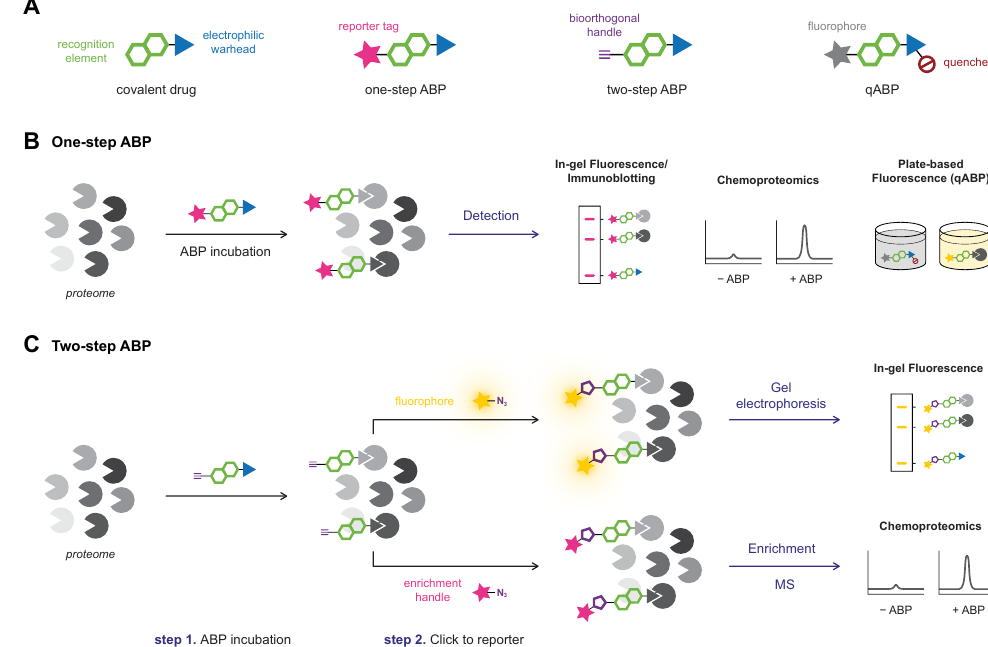
Figure 9. Strategies for covalent adduct detection with drug-derived activity-based probes (ABPs). ( A ) General design principle for covalent drug-derived ABPs. A fluorophore, detection tag, or enrichment handle is introduced onto the parent covalent drug bearing a recognition element and a covalent warhead. ( B ) Detection of covalently modified proteins with one-step ABPs. Proteome is treated with one-step ABP, proteins are resolved by gel electrophoresis or affinity purification, and modified targets are detected by in-gel fluorescence or immunoblotting or by chemoproteomic evaluation. ( C ) Detection of covalent adducts with two-step ABPs. Proteome is incubated with a two-step ABP bearing a small bioorthogonal handle ( step 1 ), followed by bioorthogonal coupling of a fluorophore, detection tag, or enrichment handle ( step 2 ), with subsequent analysis as shown for the one-step